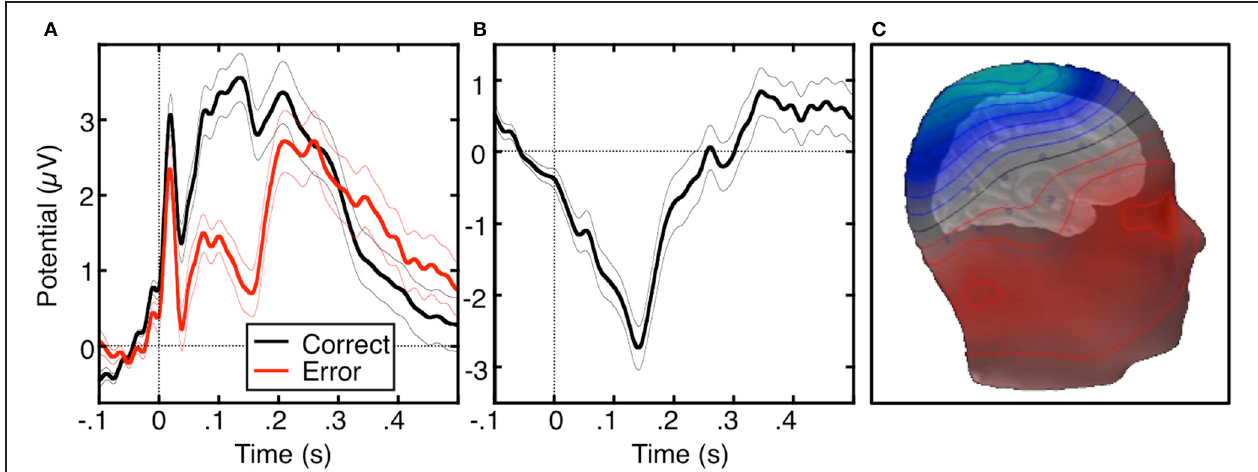
FIGURE 2 | The error-related negativity (ERN). (A) Grand average waveforms for correct (black) and error (red) antisaccade trials, time-locked to the onset of the saccade. (B) Difference waveform, obtained by